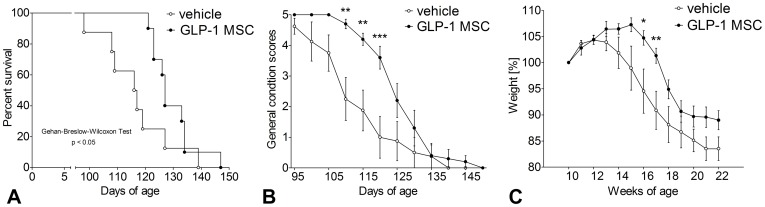
Effects of GLP-1 treatment on survival times, general condition and weight measurements.Presymptomatic GLP-1 treatment (GLP-1 MSC) prolonged survival (A) and improved general condition (B) compared to vehicle controls (vehicle). GLP-1 treated animals gained weight for a longer period than vehicle controls (C). Data are mean ± SEM of 8 (5♀/3♂) (control) and 10 (6♀/4♂) (GLP-1) treated animals. (A) Kaplan-Meyer Curve, followed by Gehan-Breslow-Wilcoxon test. (B & C) two-way ANOVA, followed by Bonferroni post-test. (**) p<0.01; (***) p<0.001.